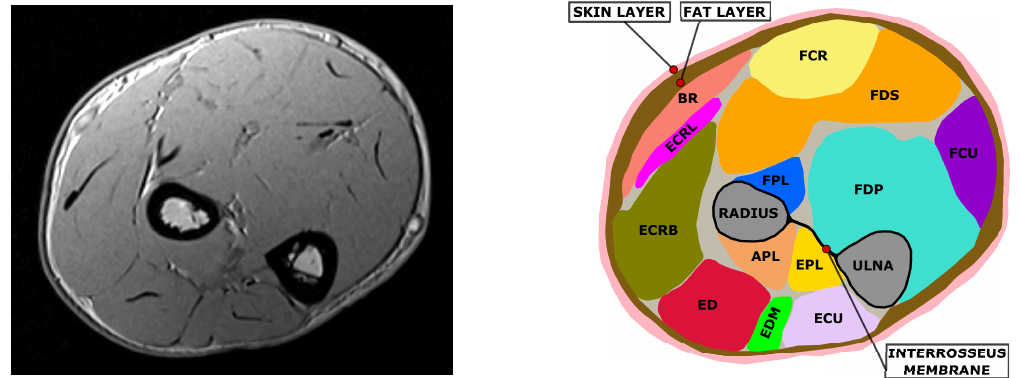
Figure 3. Example of segmentation on an MRI slice. On the left the original MRI is depicted, on the right its segmentation is reported. Muscles are represented with different colors, the radius and ulna bones are reported in gray. It is possible to observe the interosseus membrane connecting ulna and radius and dividing the posterior and the anterior side muscles. Skin and fat layers are colored respectively in pink and